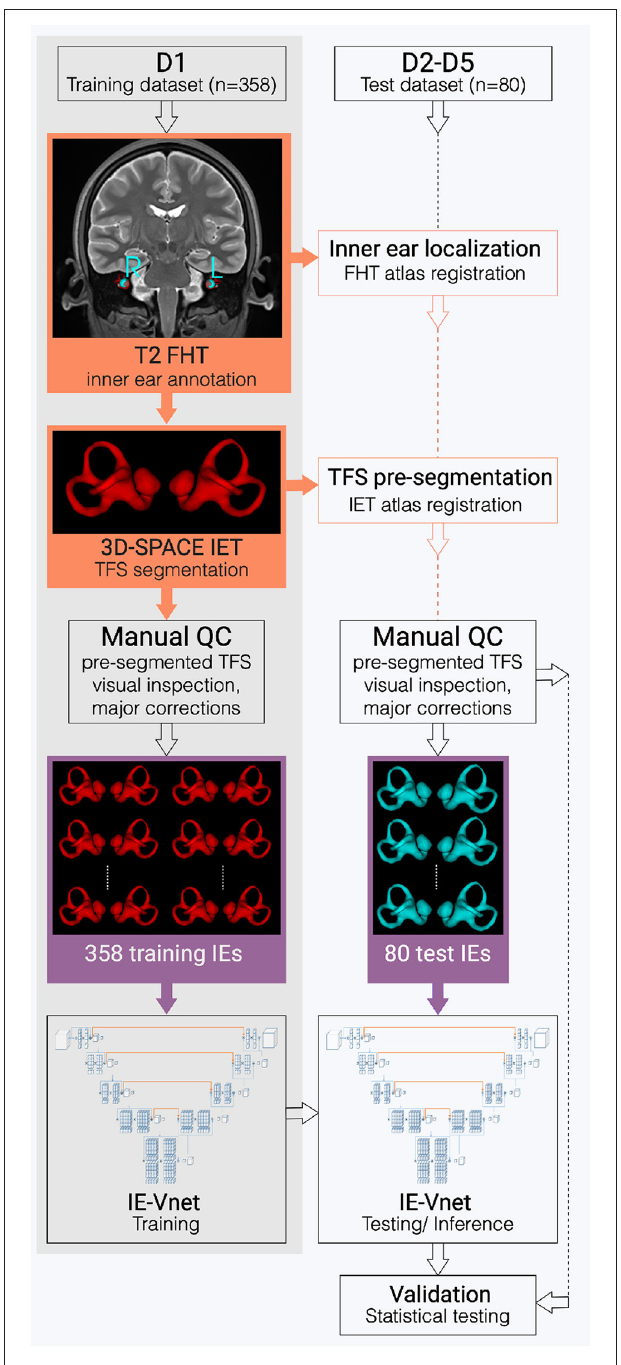
FIGURE 1 | Flowchart of the inner ear’s auto-segmentation. Auto-segmentation of the inner ear (IE) involved data preparation and manual ground-truth annotation of the IEs total fluid space (TFS) masks in training (D1, grey shading) and test (D2-D5, white shading) datasets. First, pre-segmentations (orange boxes) were obtained in D1-D5 via a custom-built full-head template (FHT) and an inner-ear template (IET). Then, manual quality control (QC), followed by manual refinement of IE segmentations (purple boxes), trained and examined the IE-Vnet model. Finally, its predictions were validated under various forms of domain shift in the test datasets D2-D5 (cf. Table 1